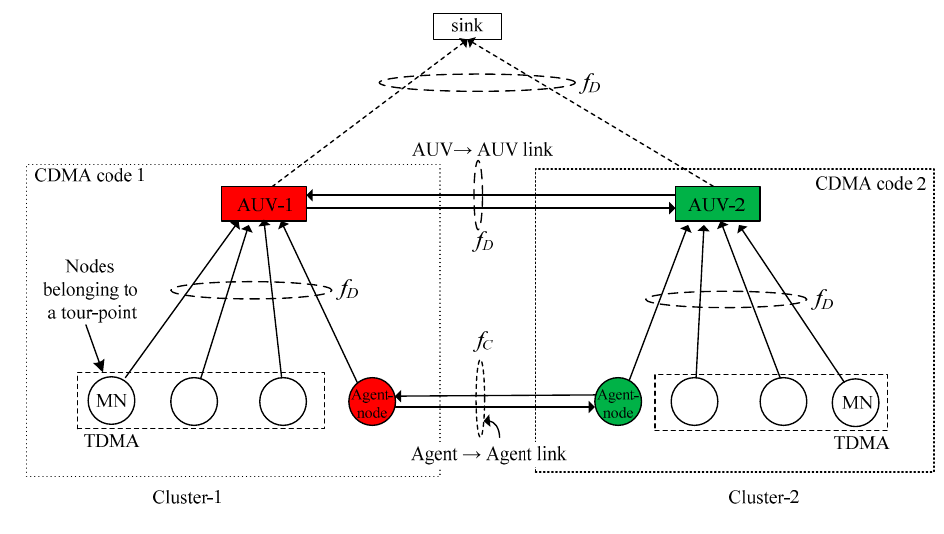
Figure 3. Medium-access scheme.